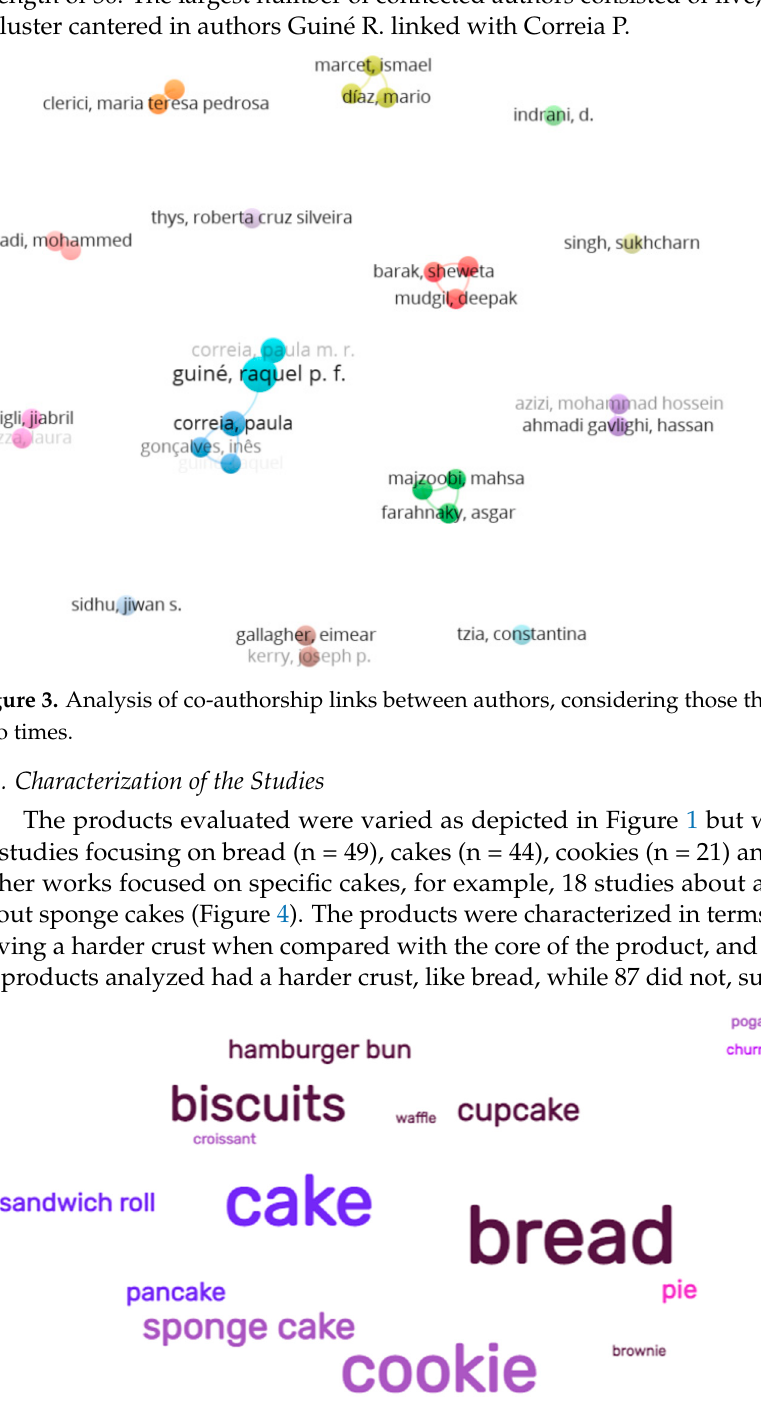
Figure 2. Analysis of co-occurrence links between keywords, considering those that occurred at least twice.